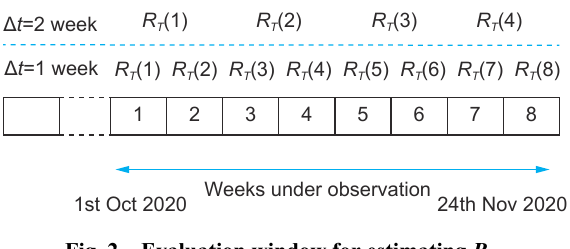
R T Fig. 2 Evaluation window for estimating